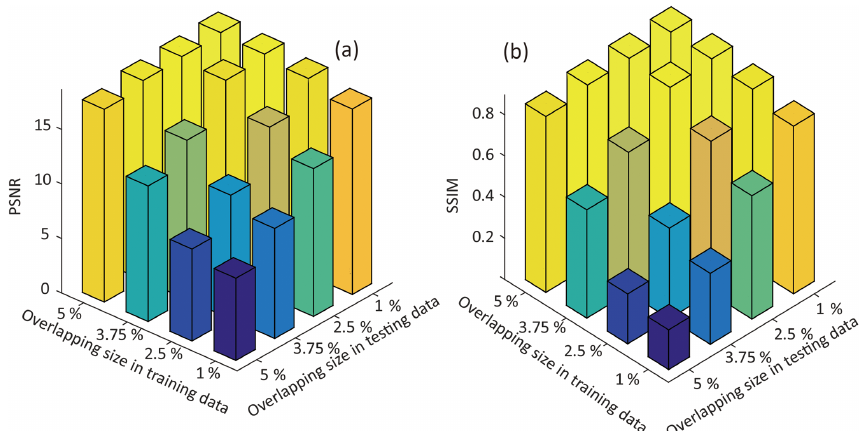
Figure A2. Effect of different degrees of EC overlap between paleovalley and non-paleovalley cells on model performance using (a) PSNR and (b) SSIM